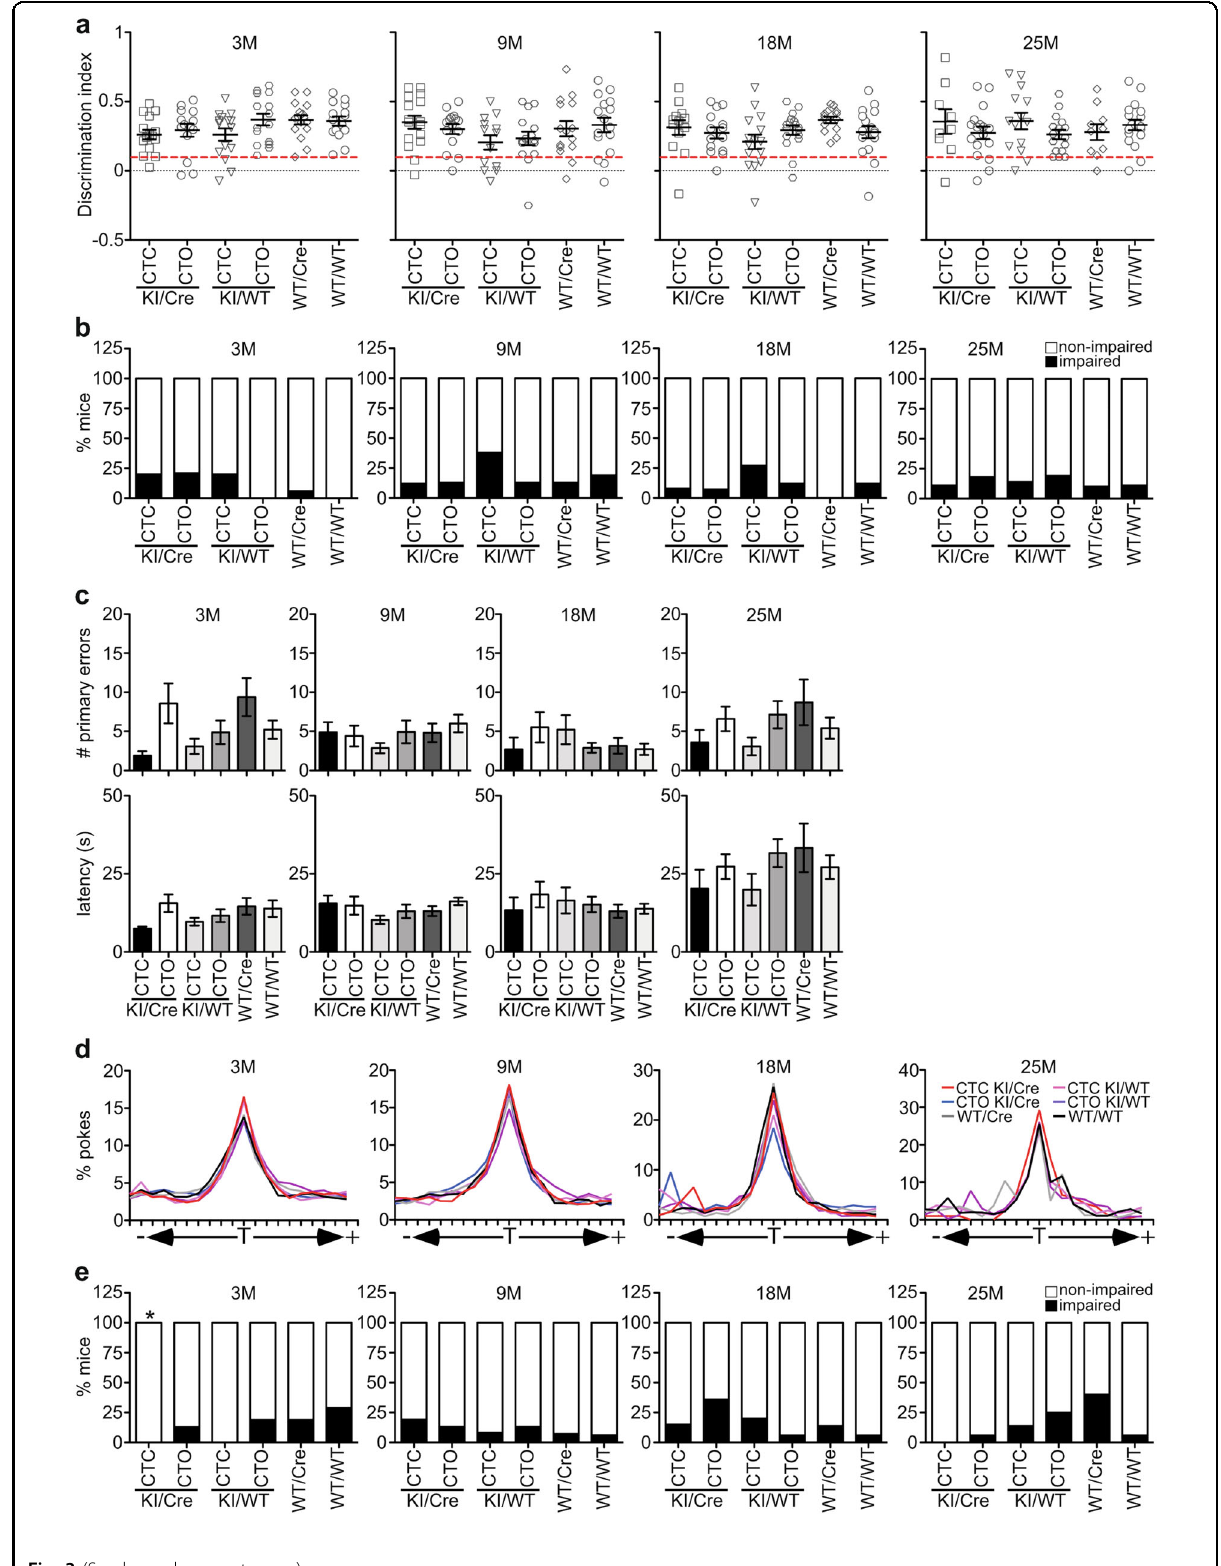
Fig. 3 (See legend on next